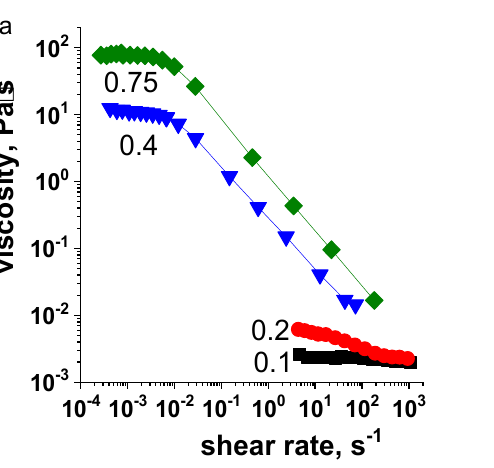
Figure 3. ( a ) Viscosity as a function of shear rate for solutions of different EHAC concentrations: 0.1 wt.% (squares), 0.2 wt.% (circles), 0.4 wt.% (triangles), 0.75 wt.% (diamonds). ( b ) Zero-shear viscosity as a function of EHAC concentration in 1.5 wt.% KCl at 25 °C.